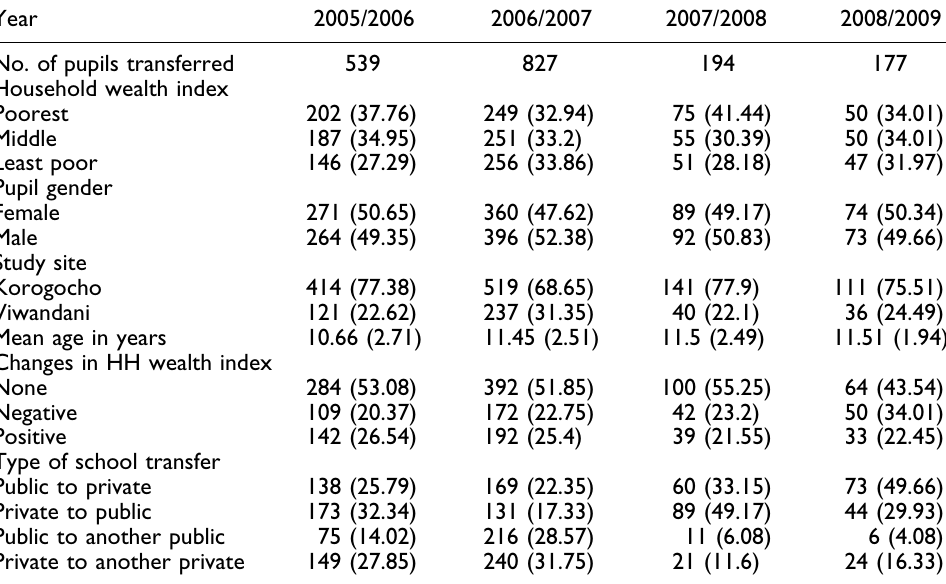
Table 1. Background characteristics of school transfers by schooling year.